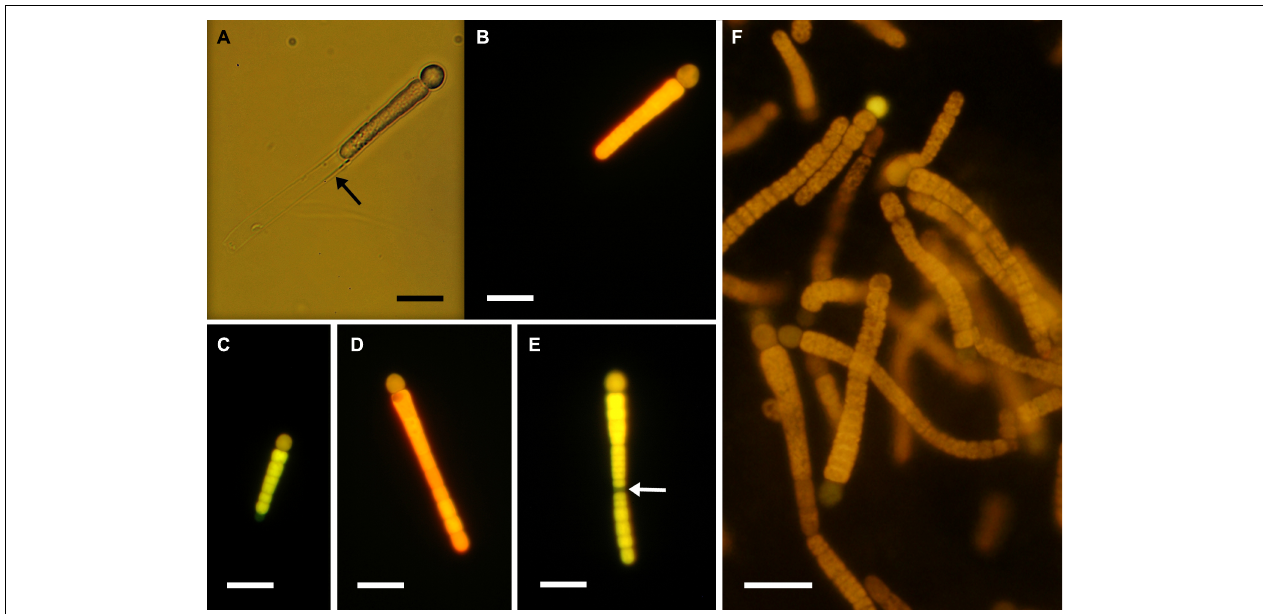
FIGURE 4 | (A–E) Solitary or (F) clumping filaments of Calothrix rhizosoleniae strain M15 under (A) bright field and (B–F) epi-fluorescence microscopy. Black and white arrows indicate empty sheath and necridium, respectively. Scale bar: 10 µ m.